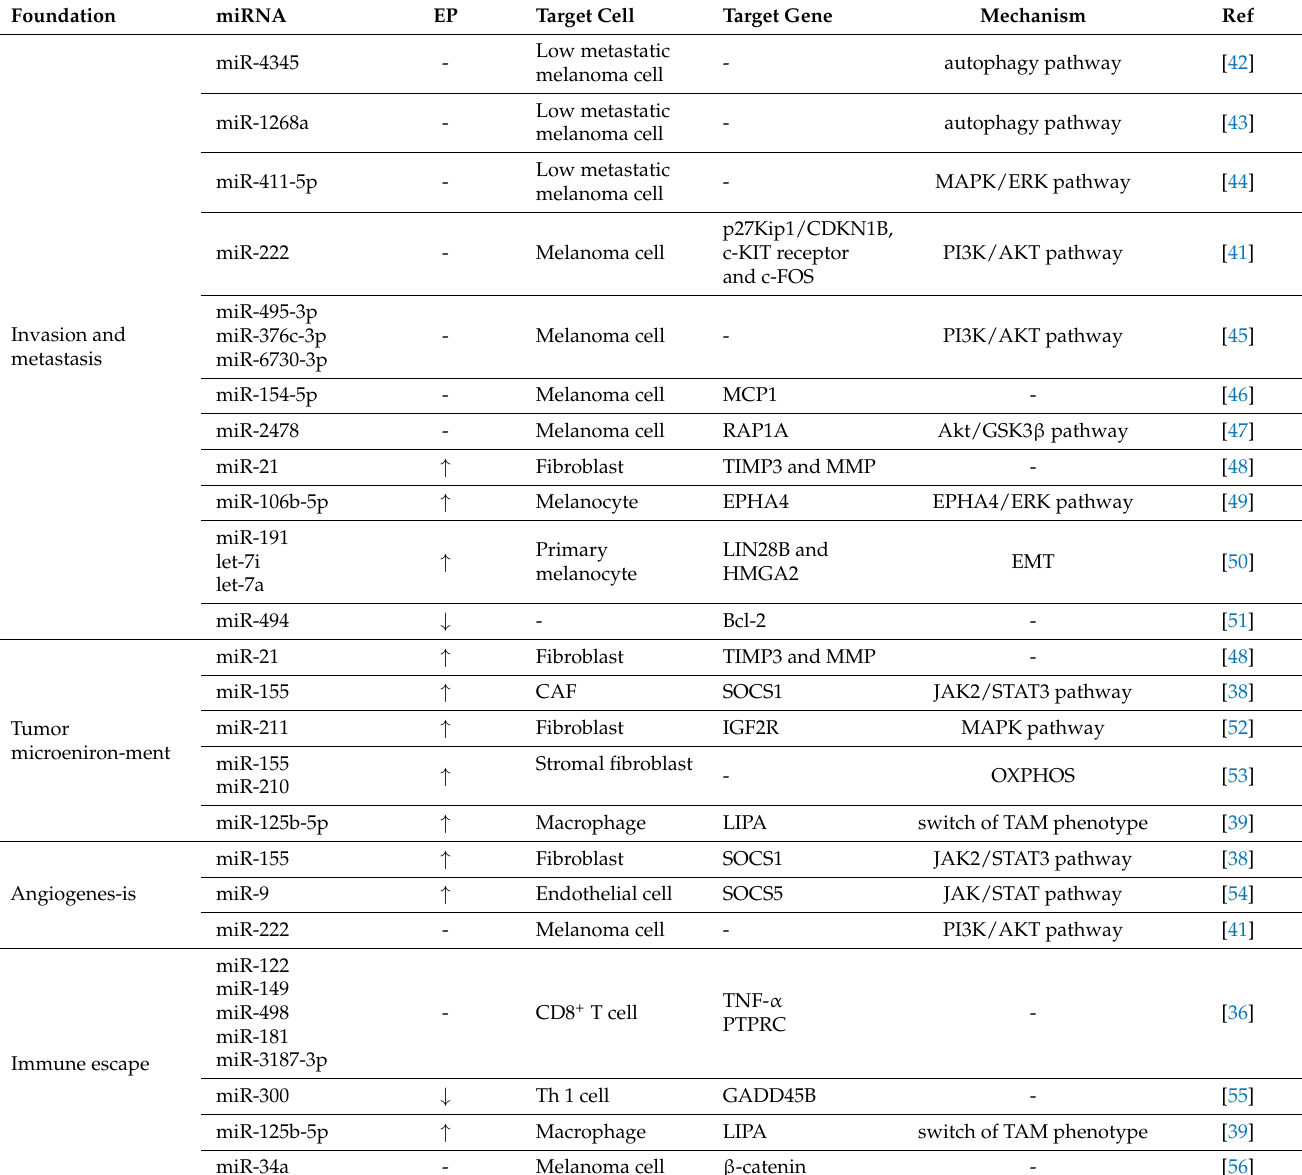
Table 1. Exosome-derived miRNAs in